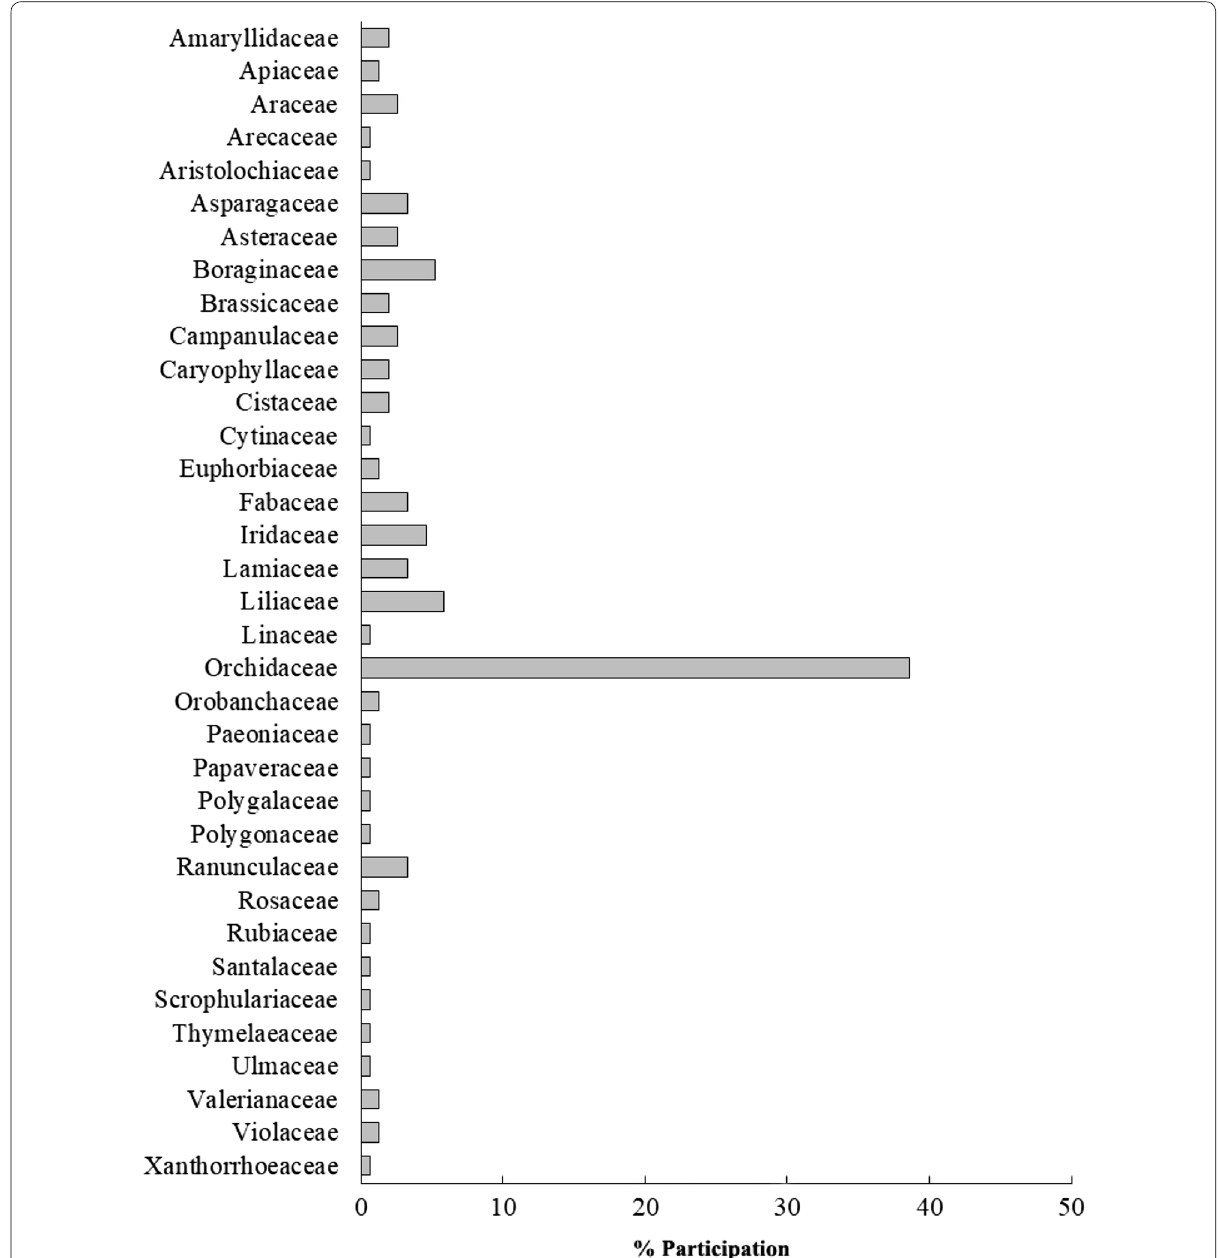
Fig. 2 Frequency of occurrence (%) of plant families represented in the webpages of agencies offering botanical tours in Crete, Greece; all members of the flora of Crete are taken into